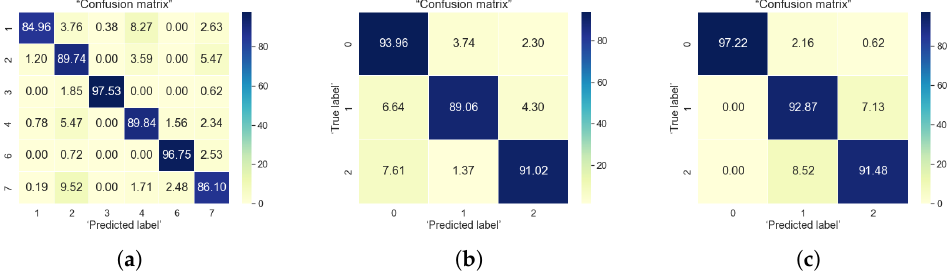
Figure 14. Confusion matrix for XGBoost algorithm using outdoor data. ( a ) User classification; ( b ) UCLA based classification; ( c ) Lubben-based